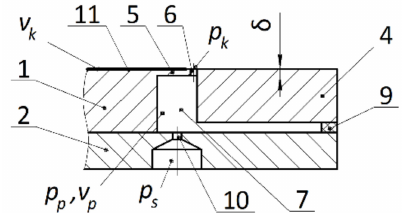
Figure 2. Diaphragms, movable part and